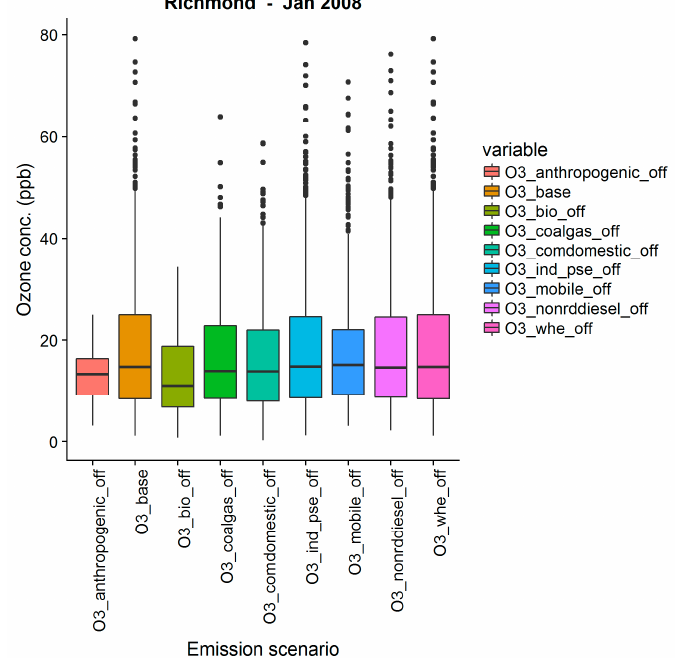
Figure 10. Box plot for 1-hour ozone concentration (ppb) in January 2008 under different emission scenarios at Richmond.